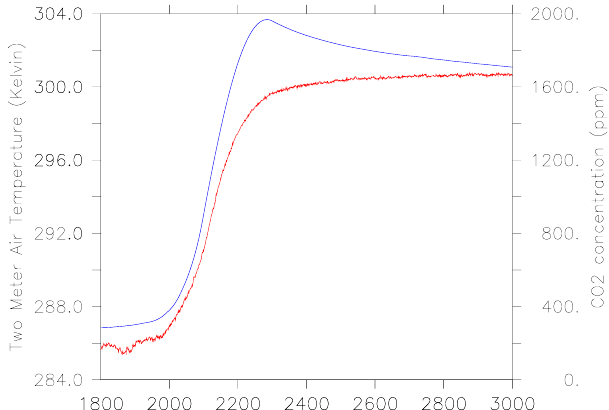
Fig. 24. The annual global mean two meter air temperature in K (red) and prescribed CO 2 concentration in ppm (blue) in the sce- nario